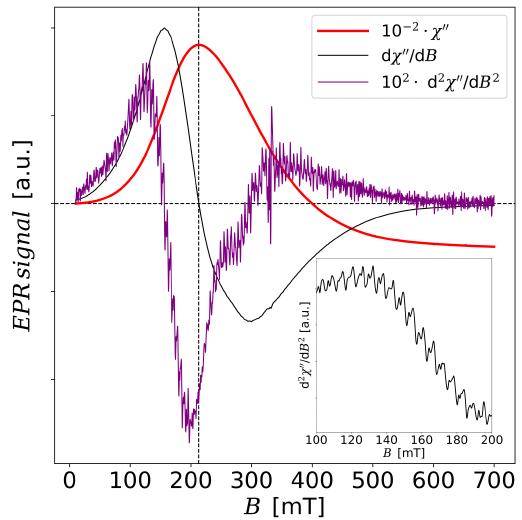
Figure 5. EPR signals (absorption line, first and second order derivative of the absorption line) of sample S1 at temperature T = 290 K. The plots have been rescaled for greater clarity. The inset shows a fragment of the second derivative of the absorption